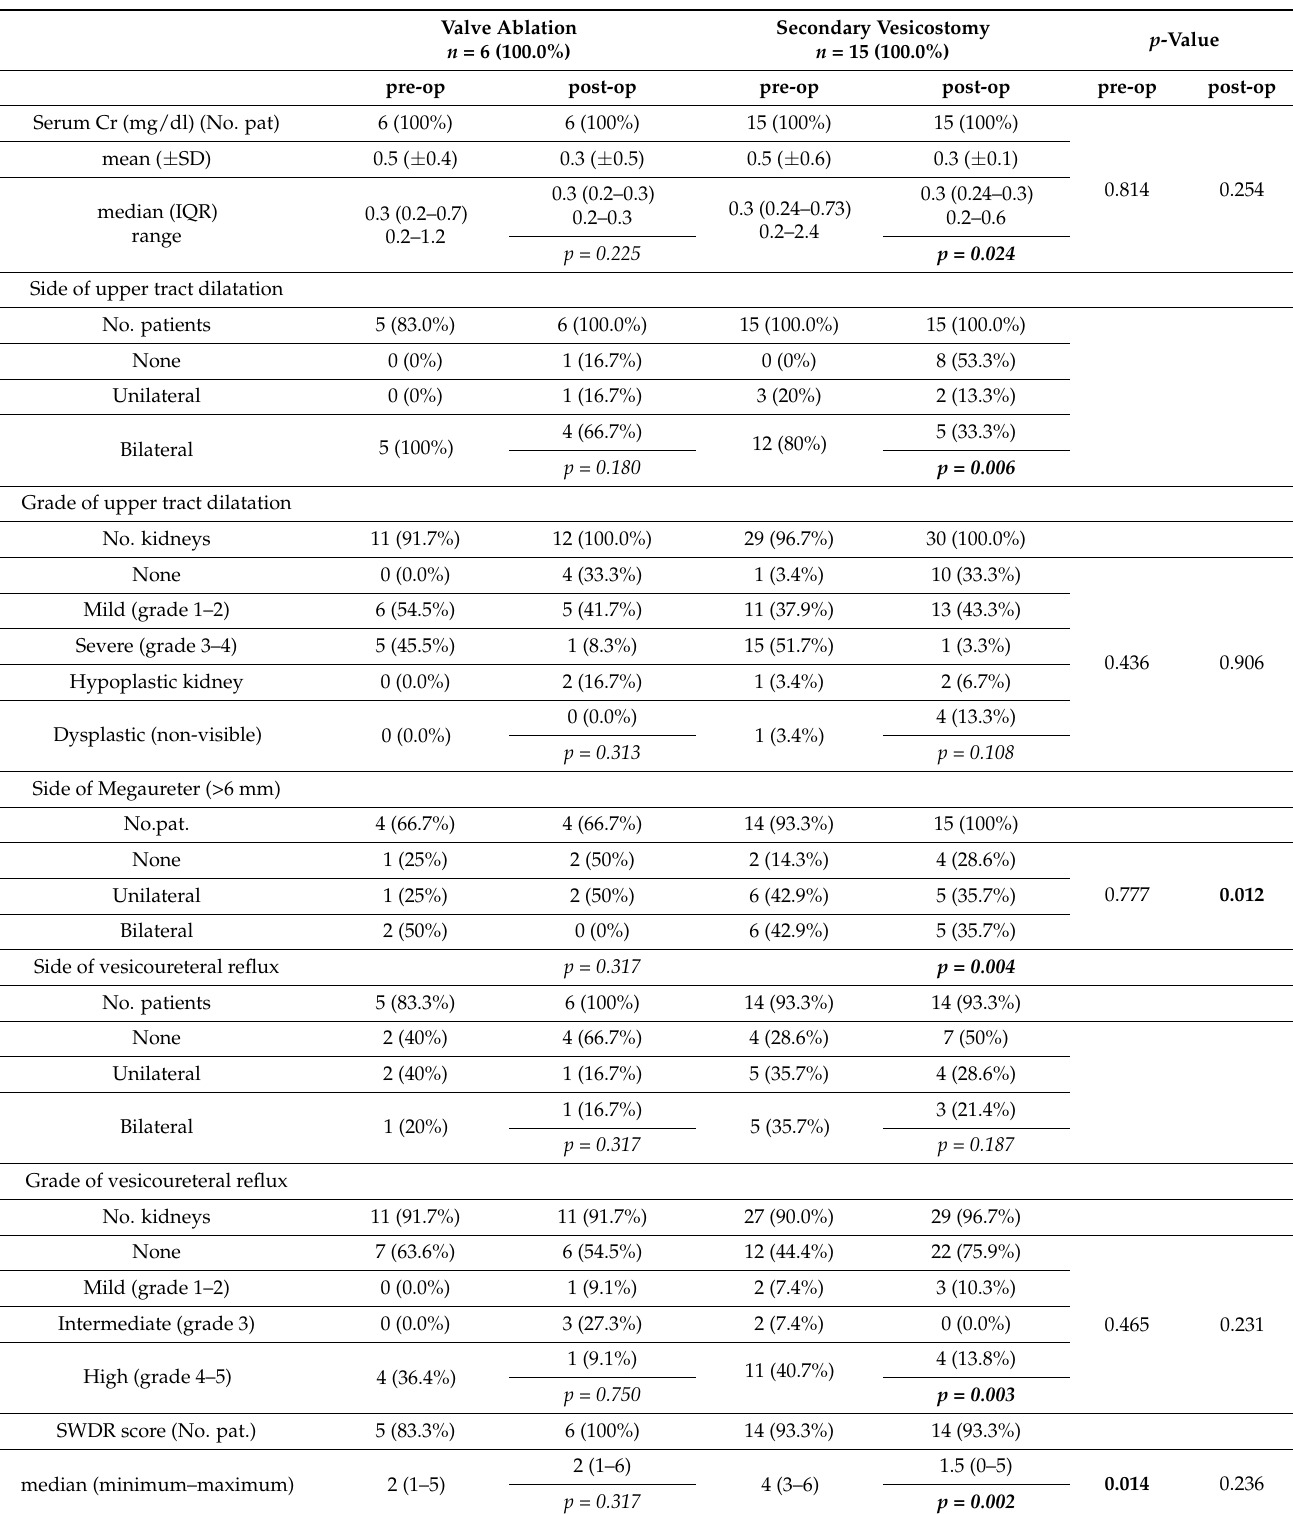
Table 2. Initial and follow-up changes of laboratory values as well as sonographic and radiologic